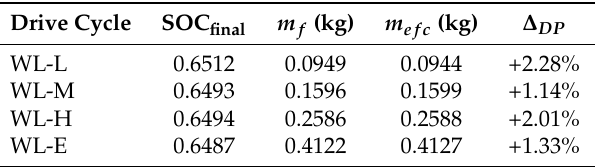
Table 9. Fuel Economy results for TTS